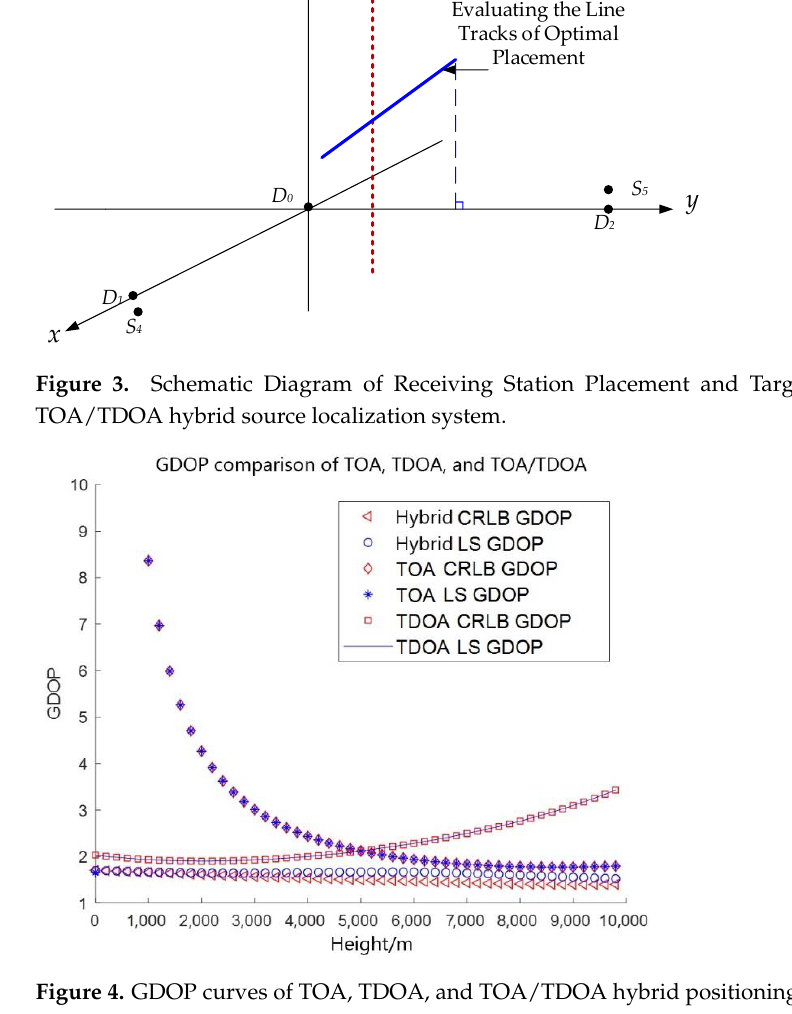
Figure 3. Schematic Diagram of Receiving Station Placement and Target Line Trajectory for TOA/TDOA hybrid source localization system.